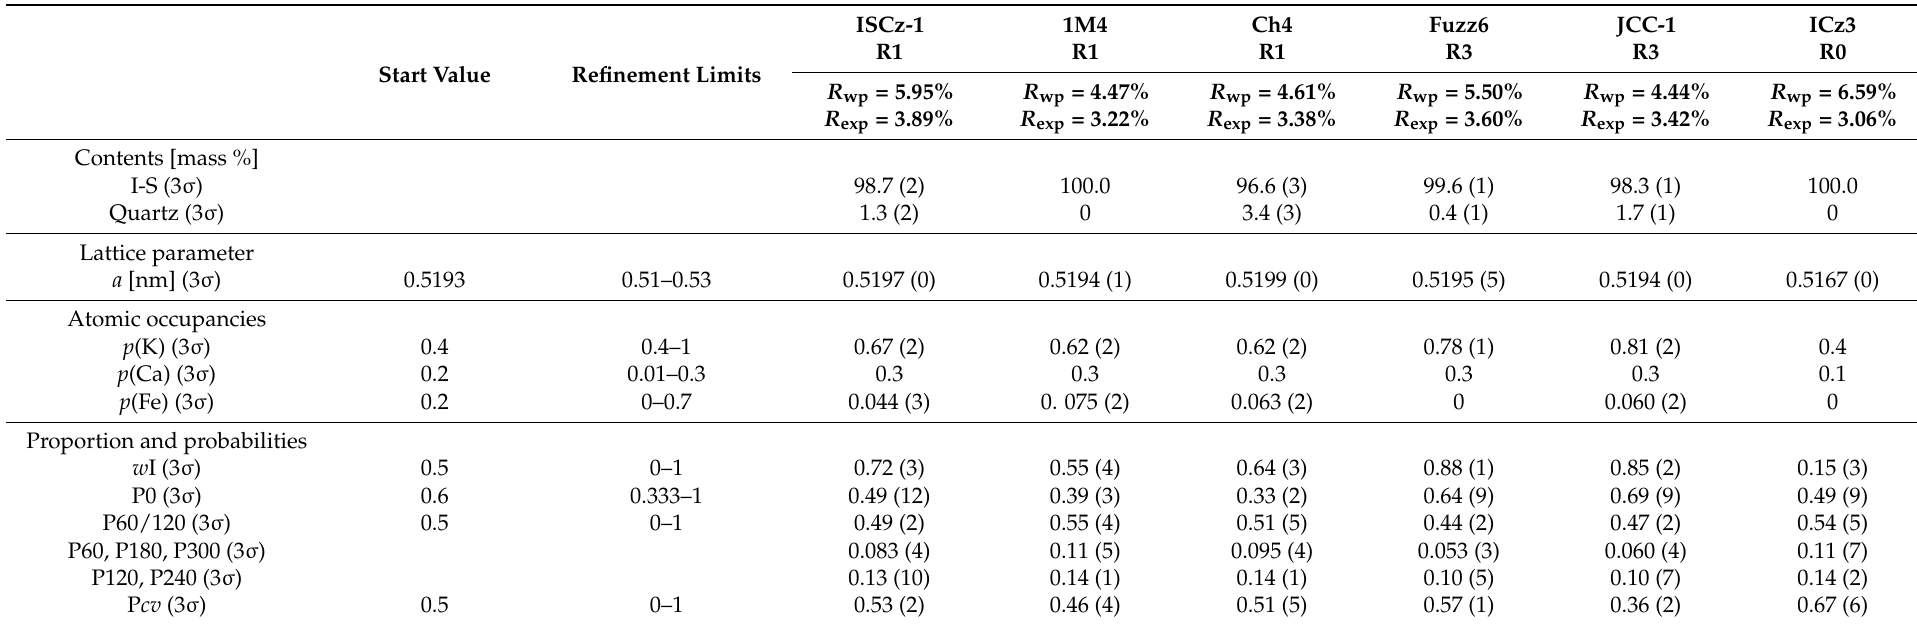
Table 8. Refinement results of powder